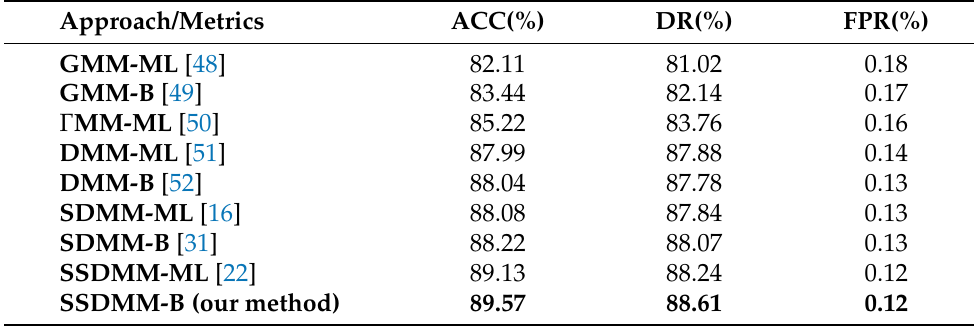
Table 2. Overall accuracy for chest x-ray (CXR)-COVID